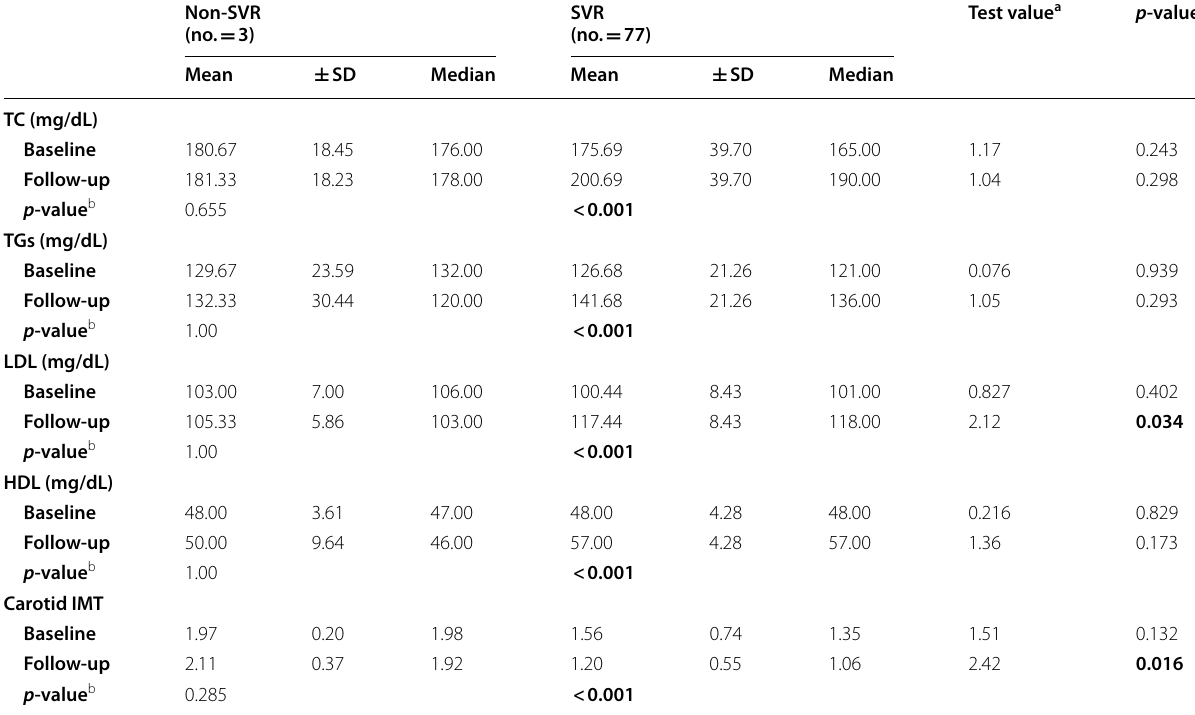
p 0.05 is considered statistically significant; p 0.01 is considered highly statistically significant. a Mann-Whitney U -test. b Wilcoxon signed-rank test. SD Standard ≤ ≤ deviation, TC Total cholesterol, TGs Triglycerides. In non-SVR patients, there was no statistically significant difference in total cholesterol, triglycerides, LDL, and HDL at baseline and follow-up ( p > 0.05), while in SVR group, total cholesterol, triglycerides, LDL, and HDL were significantly increased after follow-up compared to baseline ( p < 0.001). It was noticed that LDL was significantly higher in SVR group compared to non-SVR after treatment ( p SVR group compared to non-SVR ( p =